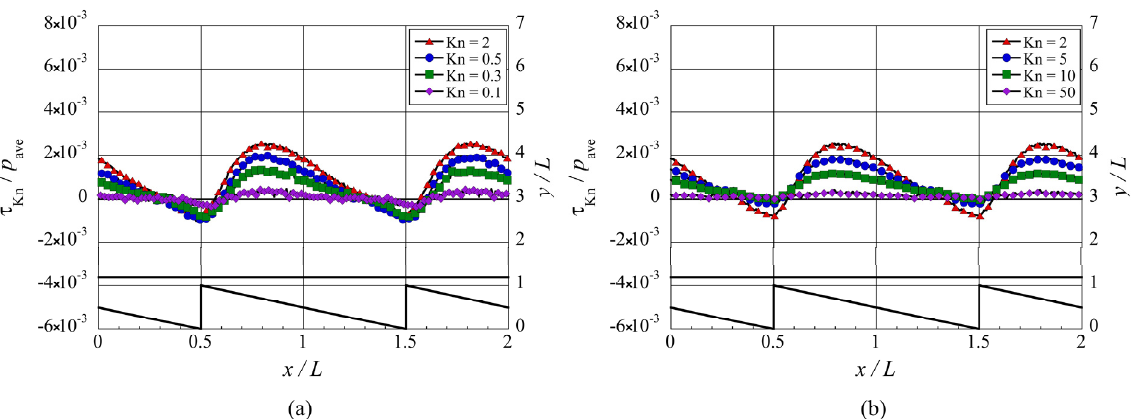
Figure 11. Distributions of the local tangential Knudsen stress, i.e., local propulsive force per unit area, for the ratchet microstructure, at ( a ) selected lower Knudsen numbers, Kn ≤ 2 , and ( b ) selected higher Knudsen numbers, Kn ≥ 2 .